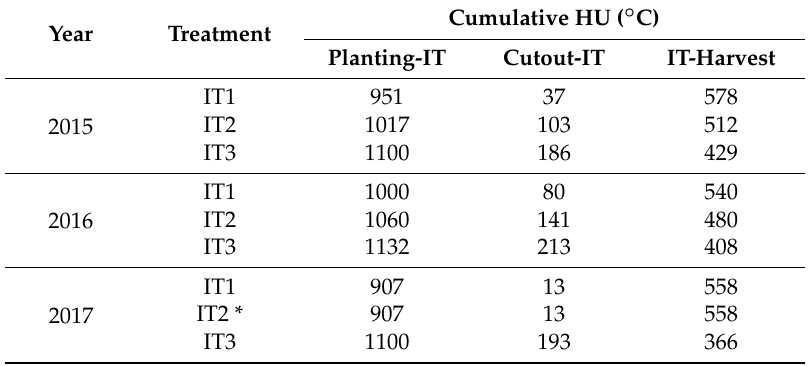
Table 8. Cumulative heat units (HU) during different periods of the growing season. Cumulative HU ( ◦ C) Year Treatment Planting-IT